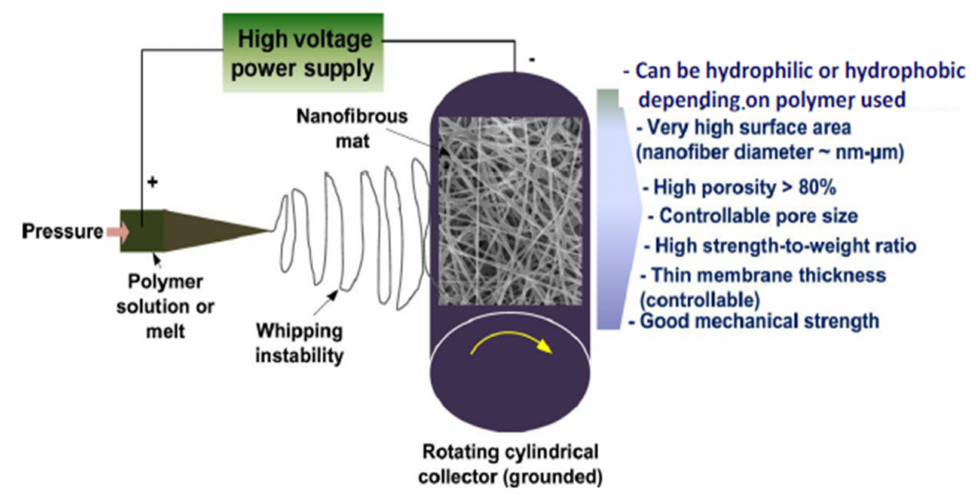
Figure 9. Electrospinning setup [92]. Reprinted/adapted with permission from Ref. [92]. Copyright 2022,